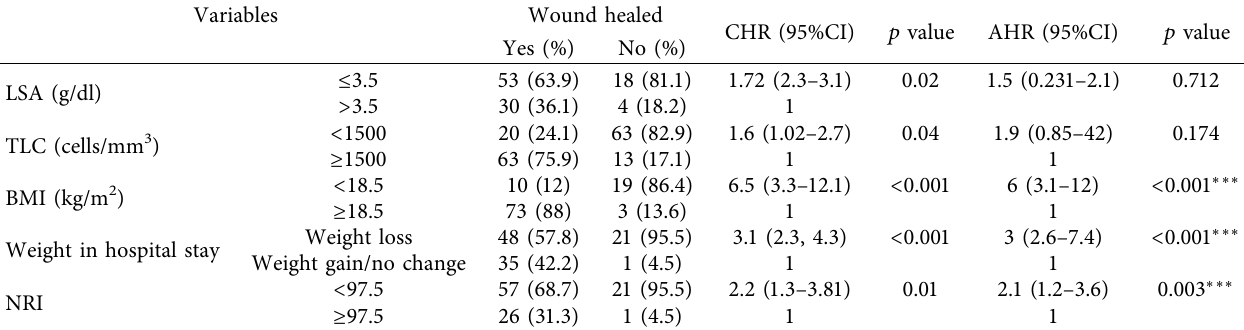
Table 4: Factors associated with poor wound healing status among patients undergoing abdominal surgery in hospitals at Wolaita zone in southern Ethiopia, October